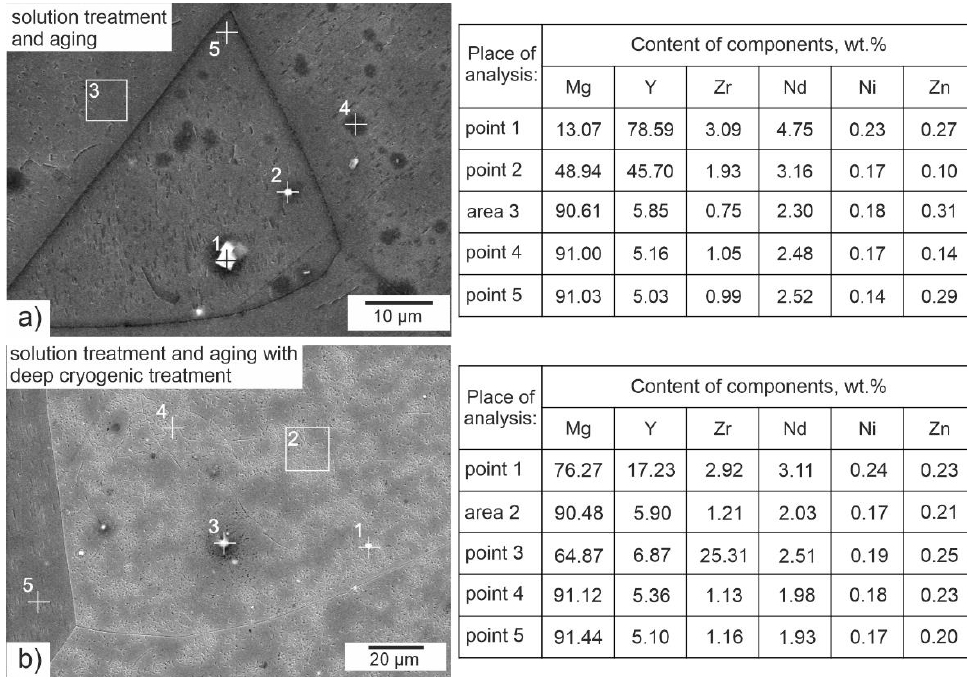
Figure 3. X-ray microanalysis using the EDS method for the Mg-Y-Nd alloy after precipitation hardening ( a ) and after precipitation hardening with a deep cryogenic treatment ( b ).